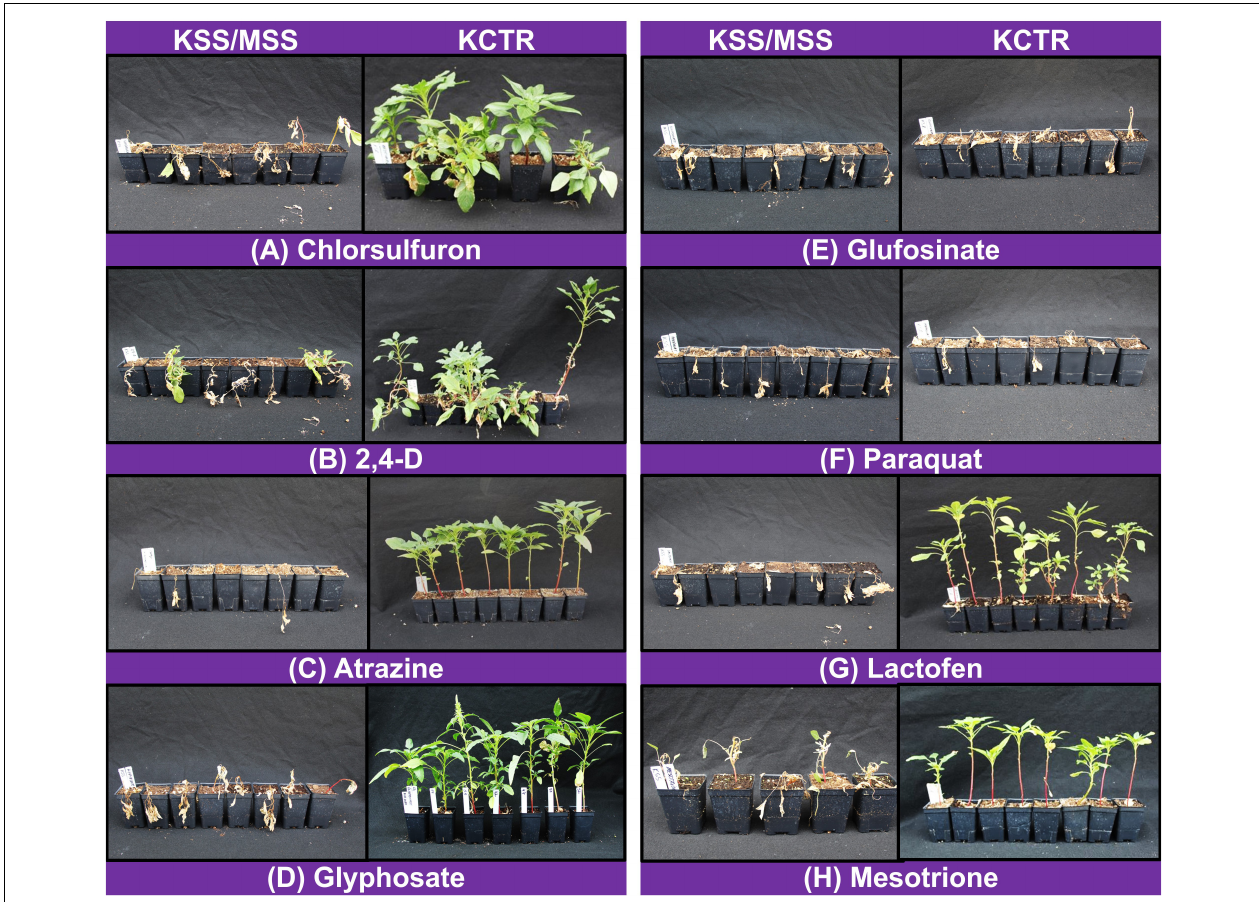
FIGURE 1 | Response of susceptible (MSS or KSS) and resistant (KCTR) Palmer amaranth to chlorsulfuron (A) , 2,4-D (B) , atrazine (C) , glyphosate (D) , glufosinate (E) , paraquat (F) , lactofen (G) , and mesotrione (H) application 2–4 weeks after treatment.